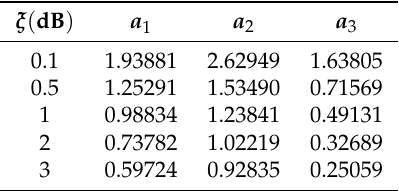
Table 1. Coefficients of the third-order Chebyshev